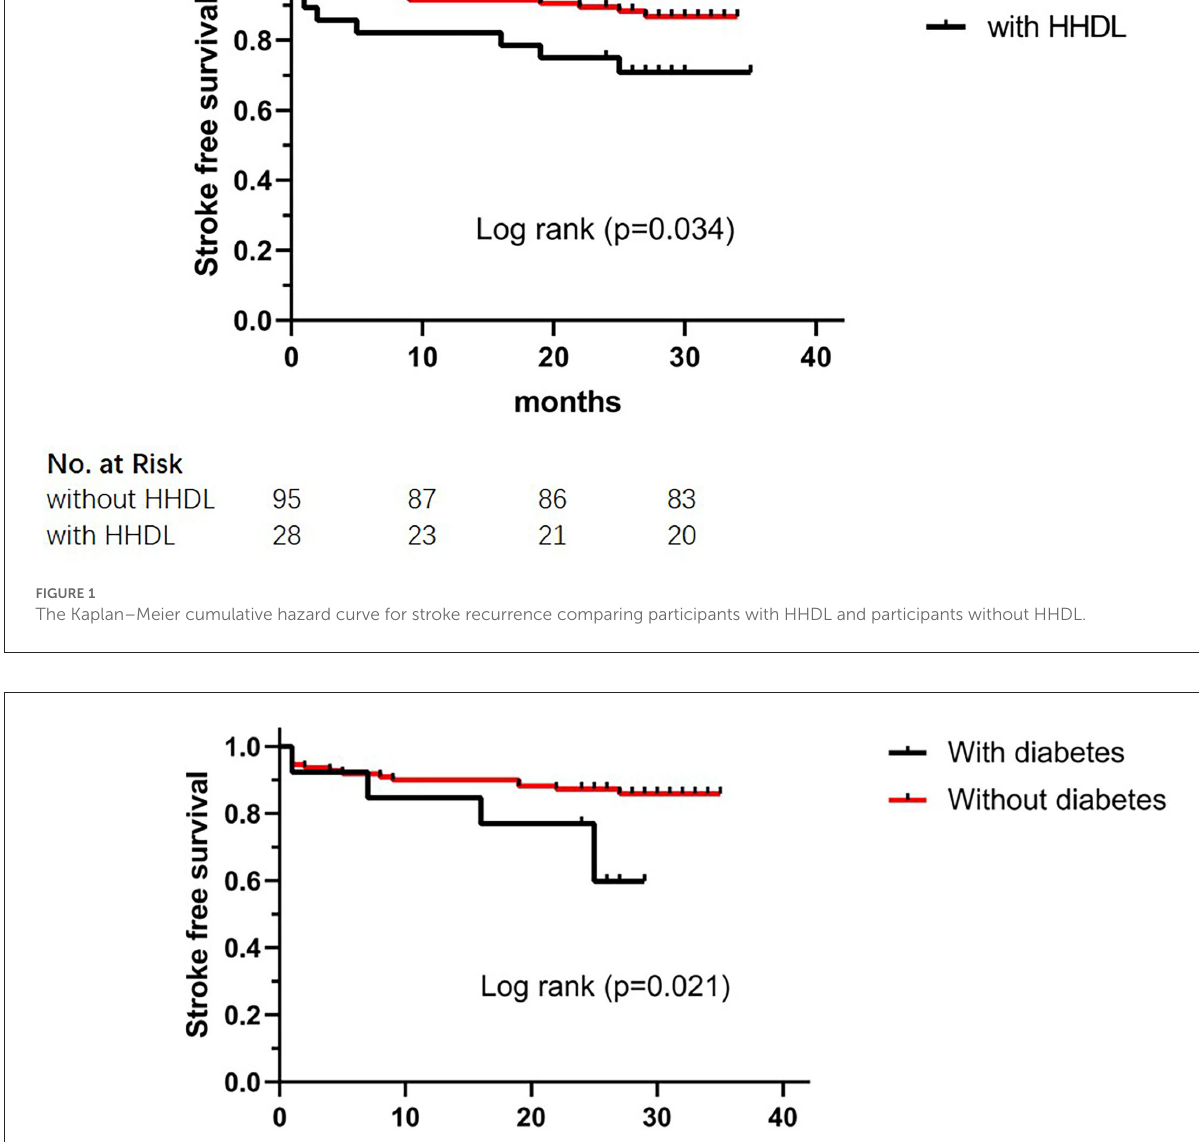
HHDL might increase the risk of ischemic stroke during the long-term follow-up (14, 15). In addition, HHDL was found to be a risk factor for the hemorrhagic stroke over the follow-up